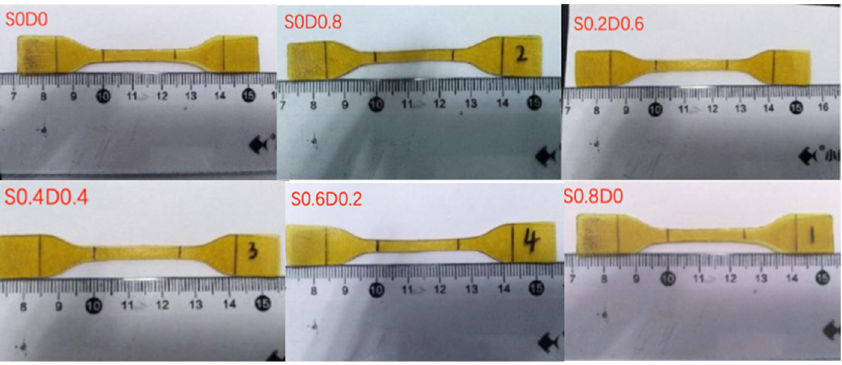
Figure 6. Shape memory test samples of PNB.